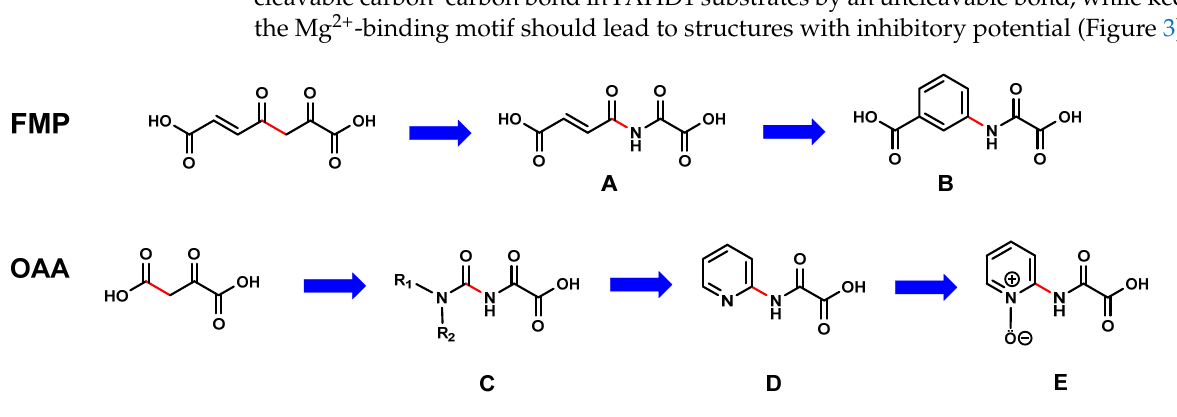
Figure 3. The design principle of the 1st-generation FAHD1 inhibitors. Upper lane: deduction of oxalamic acid ( B ) starting from substrate fumarylpyruvate (FMP); bottom lane: deduction of N -pyridyl-oxalamic acid ( D ) and corresponding 1-oxide congener ( E ) starting from oxaloacetate (OAA); (red: initial C–C bond to be cleaved in FMP and OAA and position of the corresponding bonds in the designed structures ( A – E )).